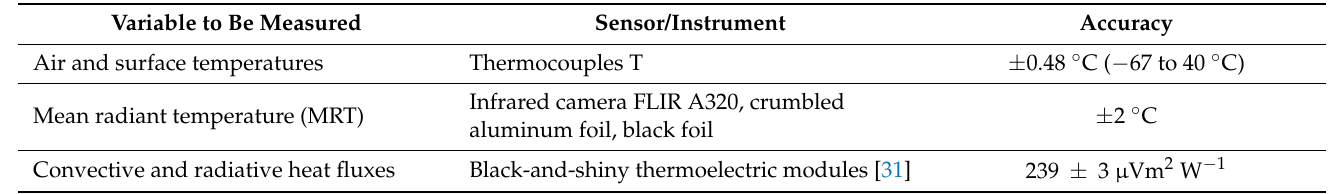
Table 2. Summary of the instruments’ characteristics implemented for local